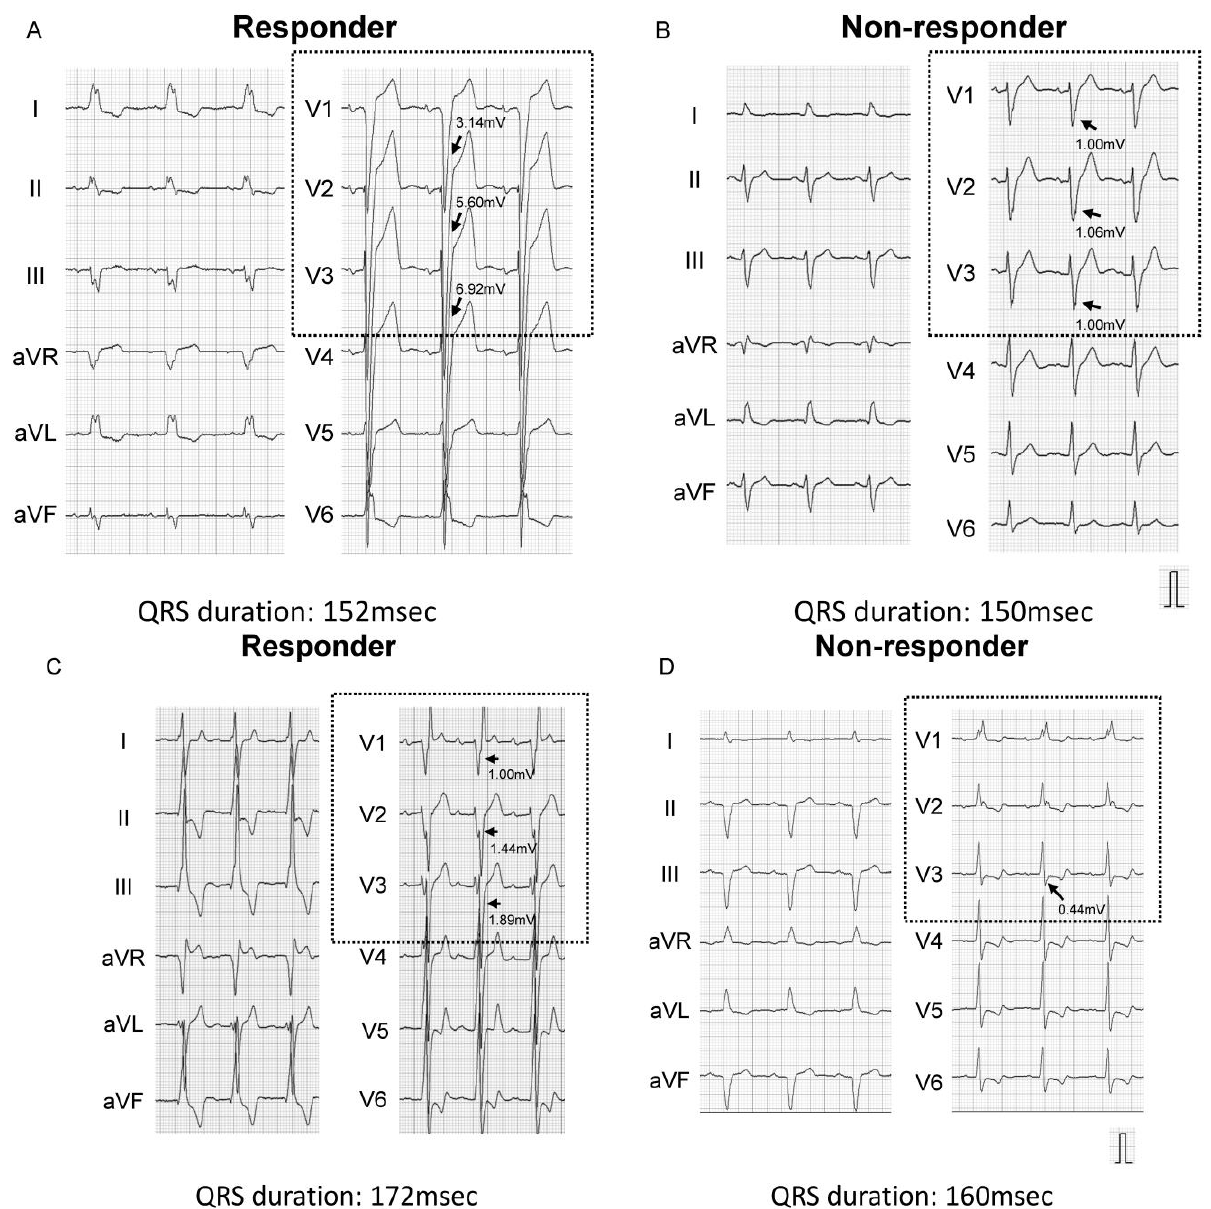
Figure 2. Representative baseline electrocardiograms (left bundle branch block ( A , B ), right bundle branch block ( C , D )). Arrows indicate S-waves in right precordial leads. ( A ) Left bundle branch block and prominent S-wave: CRT responder; ( B ) Atypical left bundle branch block and small S-wave: CRT non-responder; ( C ) Atypical right bundle branch block and notable S-wave: CRT responder; ( D ) Right bundle branch block and few S-waves: CRT non-responder. Table 3. Comparison of baseline characteristics between patients with averaged S-wave in right precordial leads <1.44 mV and those with averaged S-wave ≥1.44 mV.